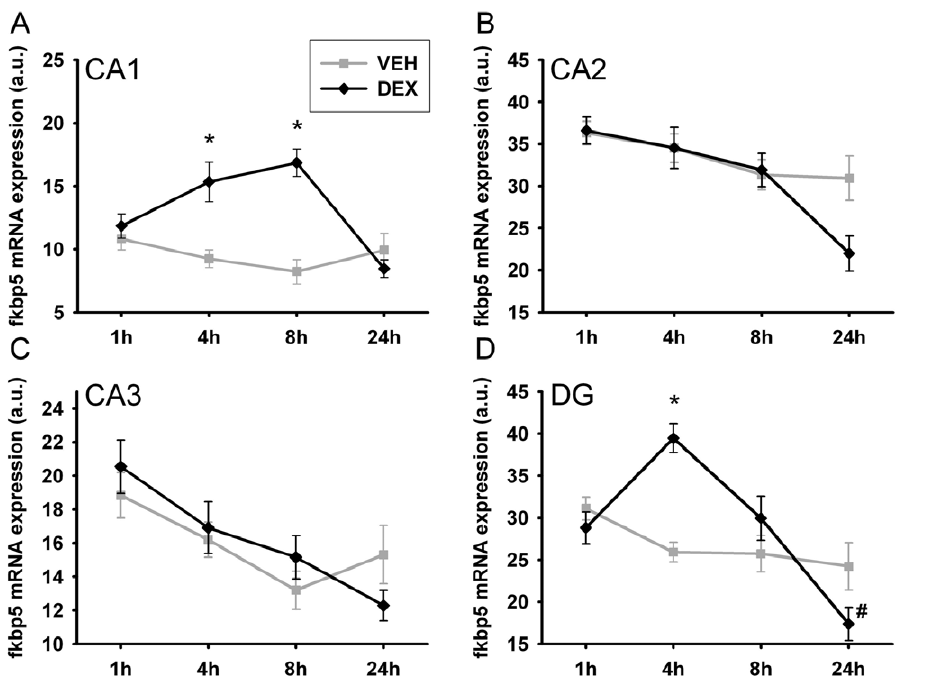
Figure 6. Temporal regulation of fkbp5 mRNA in the hippocampus following dexamethasone injection. ( A ) Modulation of fkbp5 mRNA expression in the CA1 subfield of the hippocampus. An up-regulation was found 4 and 8 h after dexamethasone treatment. ( B ) No significant overall effect was found for the CA2 region. ( C ) In the CA3 region, dexamethasone treatment had no effect. ( D ) Fkbp5 shows a differential regulation in the DG with a significant increase 4 h after injection. VEH = injected with vehicle, DEX = injected with dexamethasone. Data are given in mean 6 SEM. * different to vehicle p , 0.05, # different to vehicle p , 0.1.